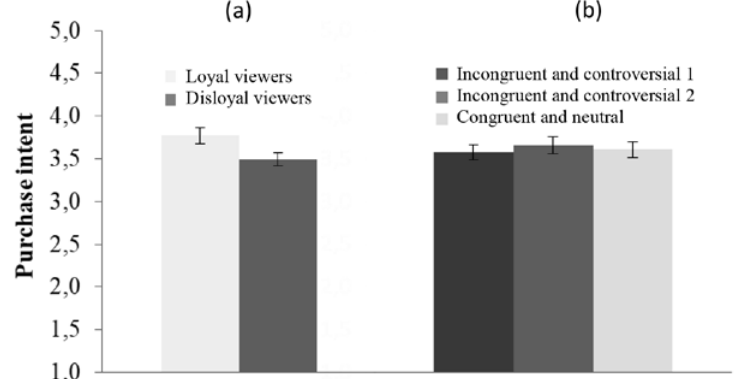
Figure 3. Differences in purchase intent for the advertised product